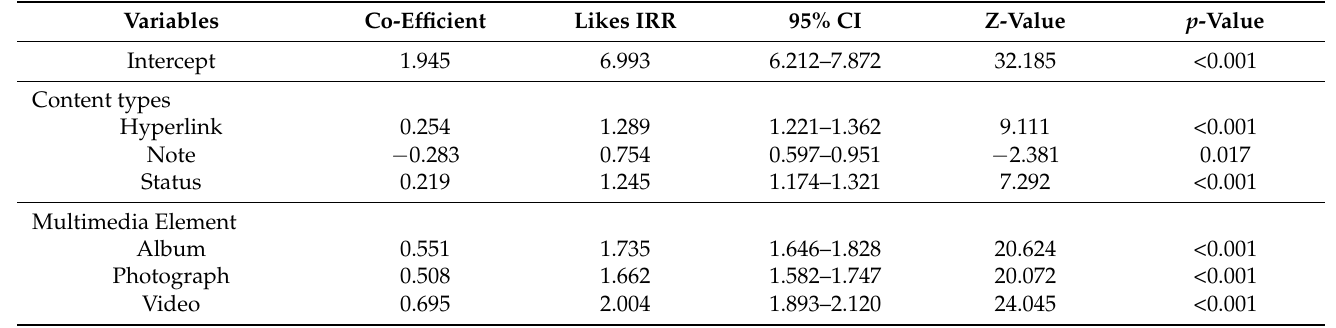
Table 4. Associations of content types, multimedia elements, message themes, and crisis stages with the level of likes (1 January to 31 December